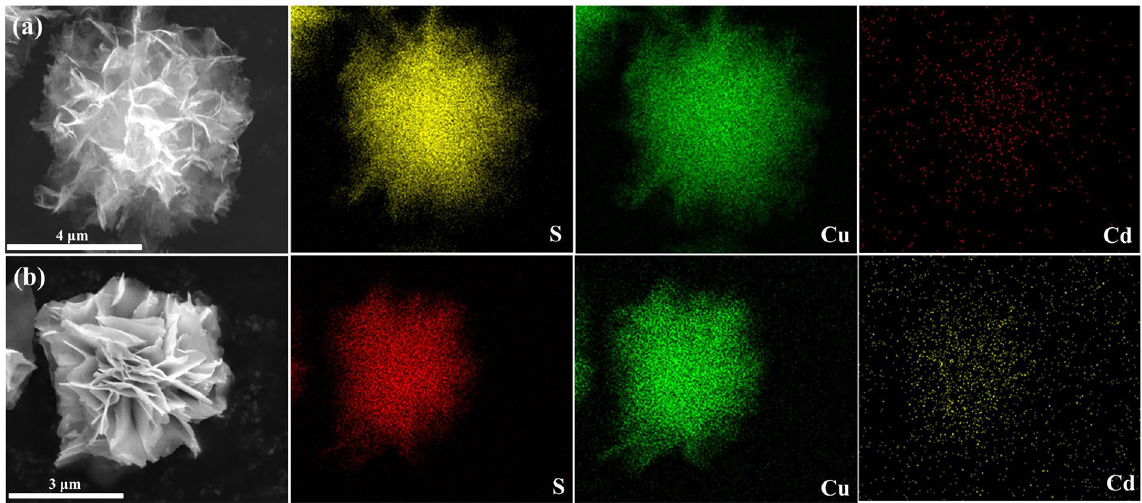
Figure 4. Typically elemental mapping images of Cd-1 ( a ) and Cd-4 ( b )